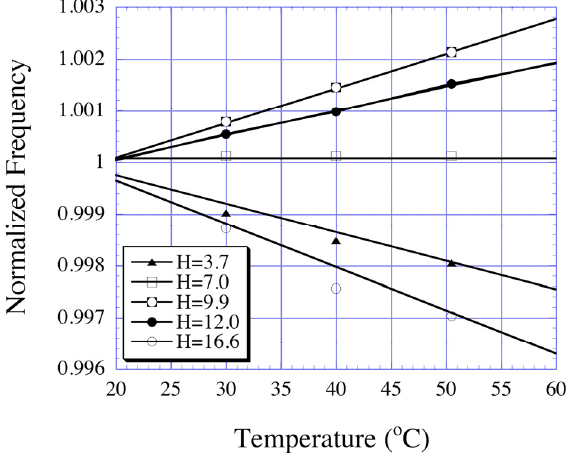
Figure 16. Measured resonance frequency as a function of temperature at different bias field amplitudes, 3.1 cm long sensor, normalized to the room temperature value. Reprinted with permission from